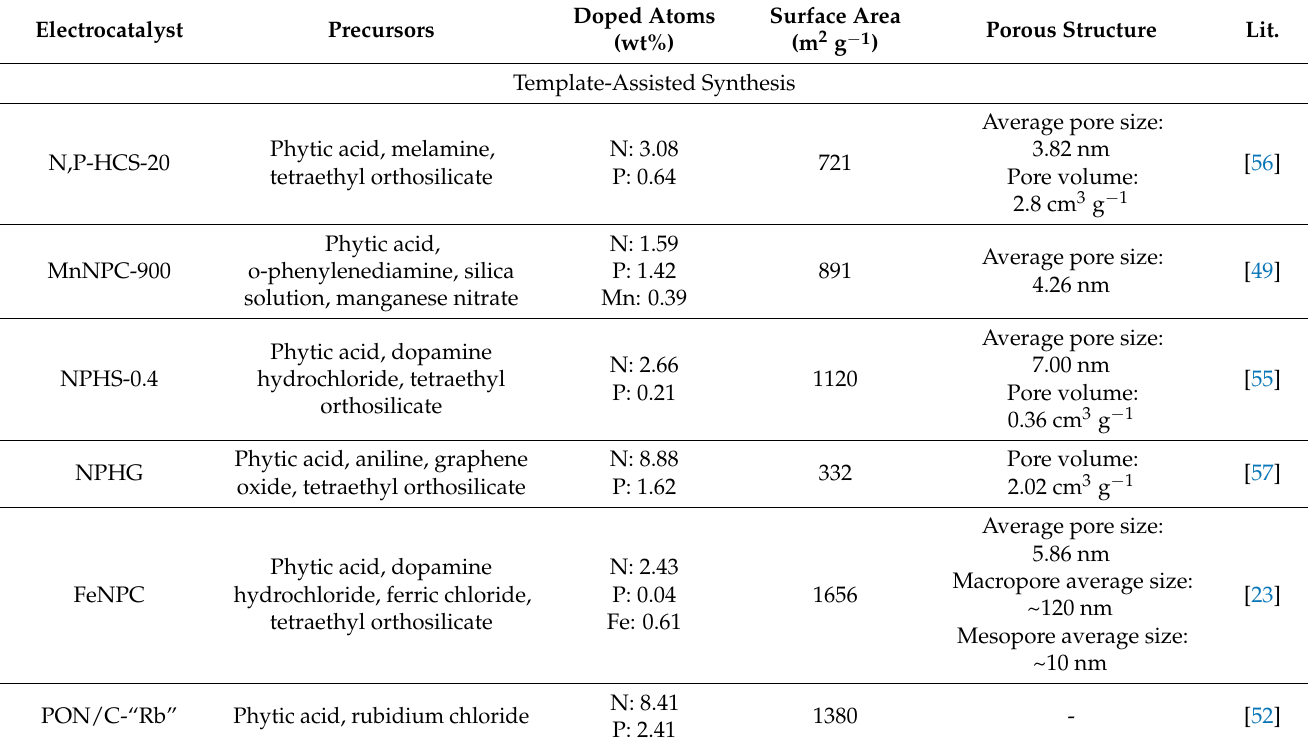
Table 2. Physicochemical properties of PA-derived carbon materials obtained via template-assisted